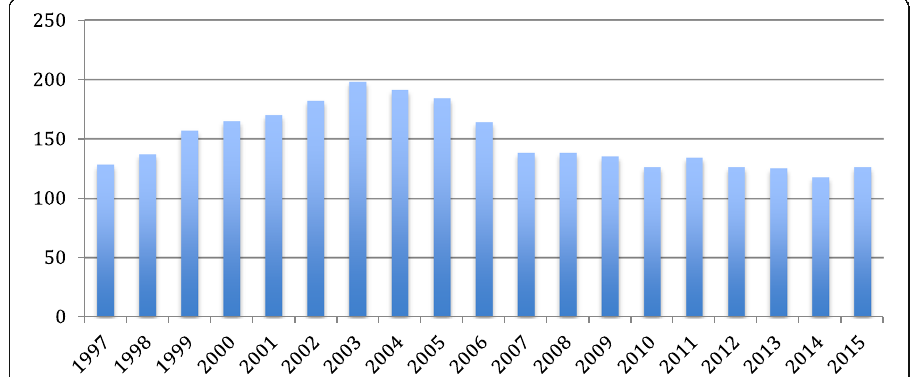
Fig. 1 Number of American Capital Companies in Lithuania (source: Statistics